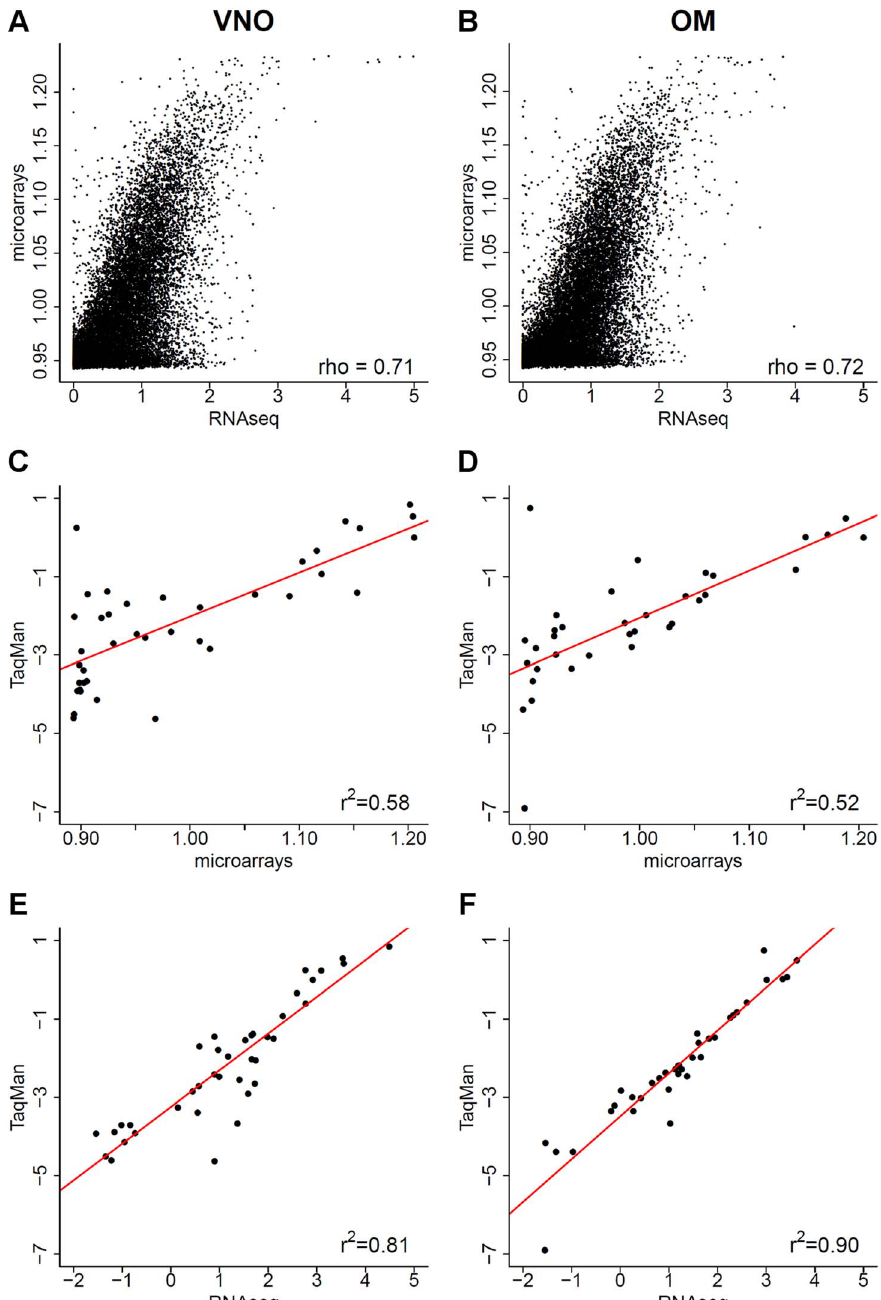
Figure 2. Comparison of RNAseq data to microarrays and qRT-PCR. (A–B) The log 10 FPKM expression values obtained from RNAseq are plotted against the normalized expression estimates from an Illumina microarray chip for the VNO (A) and OM (B), 1 was added to avoid computing log 10 (0). (C–F) For a subset of genes (Table S1), the log 10 normalized intensity values obtained from the microarrays (C–D) and from RNAseq in FPKM (E–F) are plotted against the log 10 RQ values from TaqMan qRT-PCR assays. The Pearson correlation values are indicated and a linear least squares regression is fitted (red).